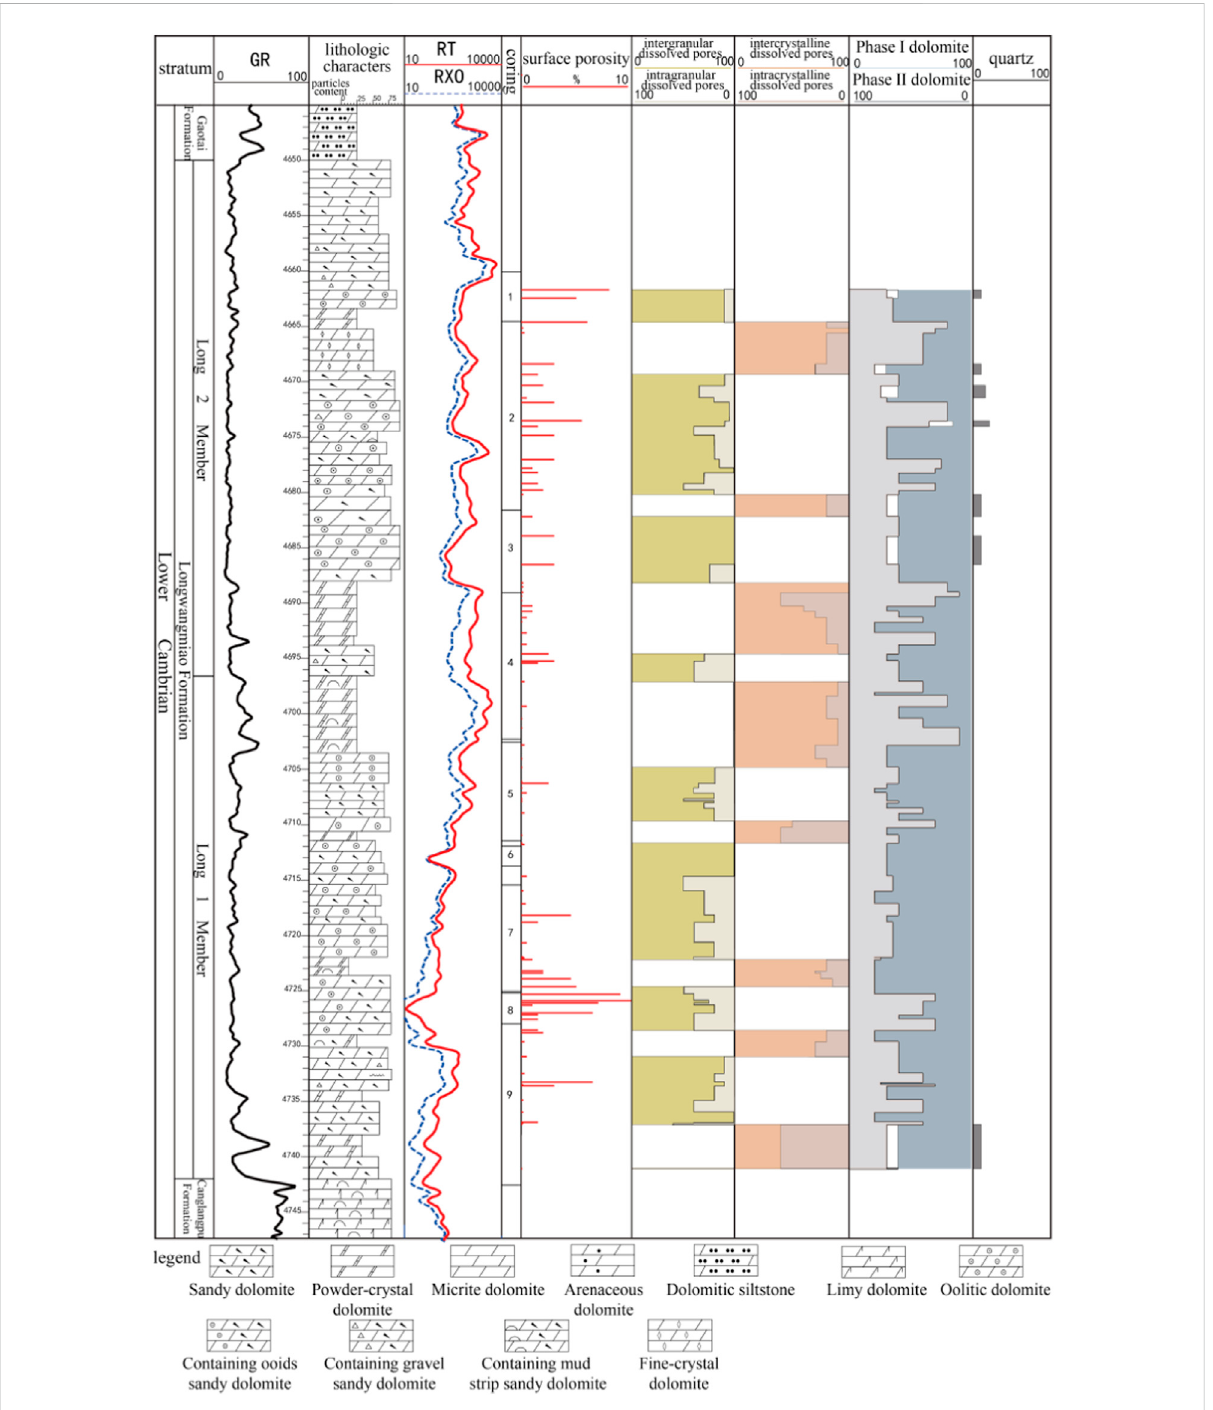
FIGURE 3 Development characteristics of pores of the Longwangmiao Formation in Well Gaoshi 23 in the study